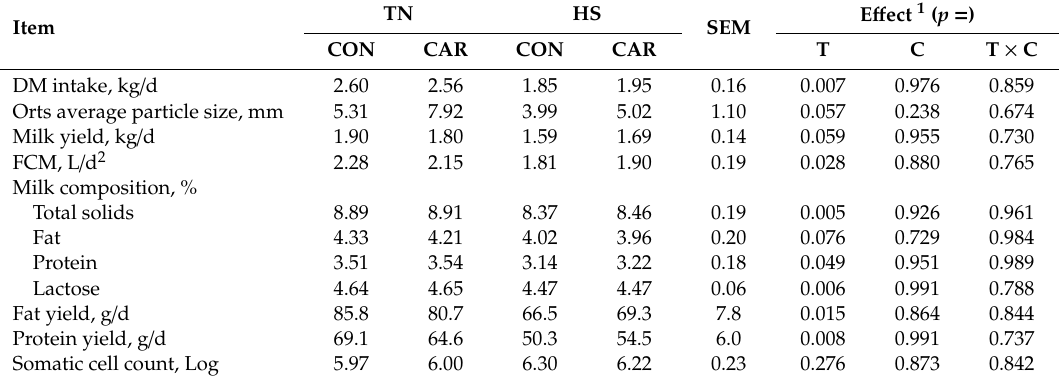
Table 4. Least squares means for feed intake, average particle size of the orts, and milk production of dairy goats under thermo-neutral (TN) or heat stress (HS) conditions. In each ambient temperature, goats were fed a control diet (CON) or supplemented with 1g L-carnitine (CAR).